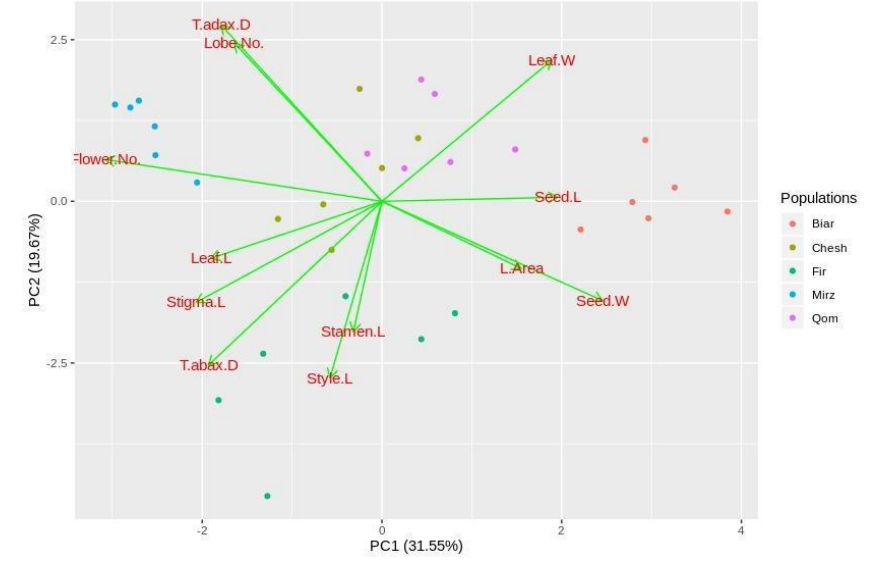
Fig. 4. PCoA analysis of morphological characteristics of five L. undulata populations in